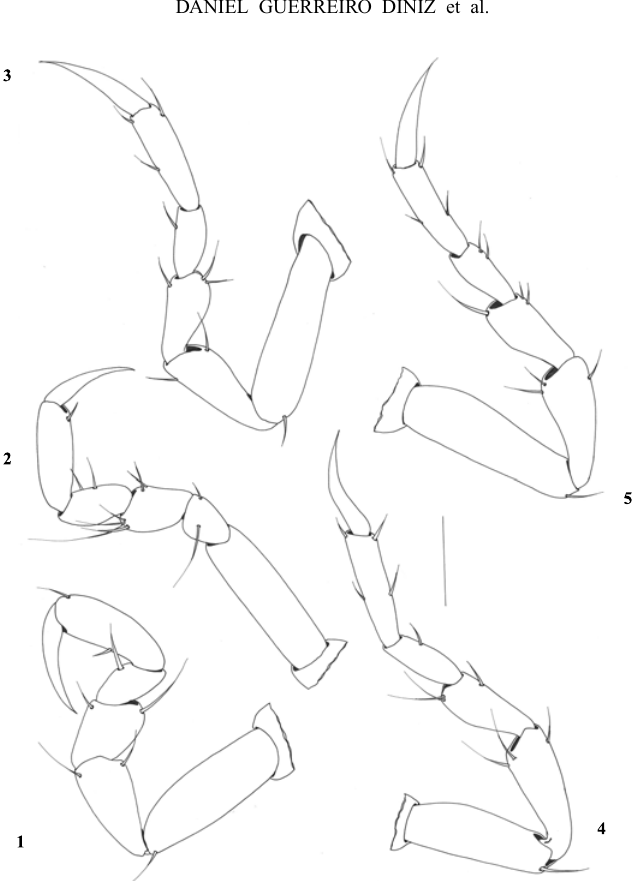
Fig. 4 – Peraeopods 1–5 of praniza larvae collected from fishes of estuarine zone of Northeast of Pará, Brazil. Bar = 150 μ